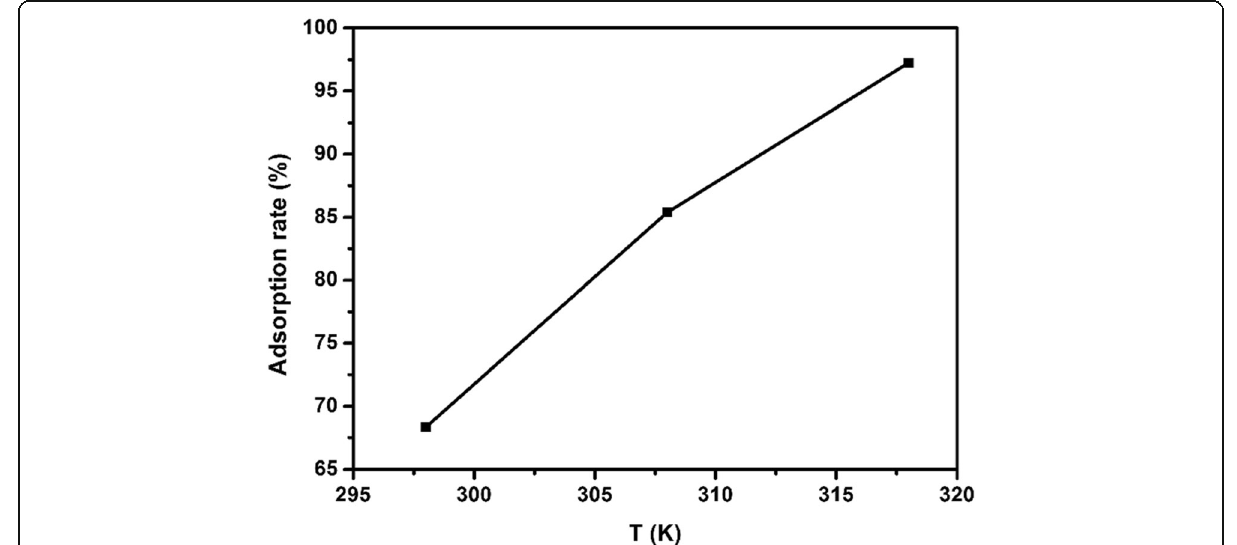
Fig. 9 Relationship between different temperatures and adsorption